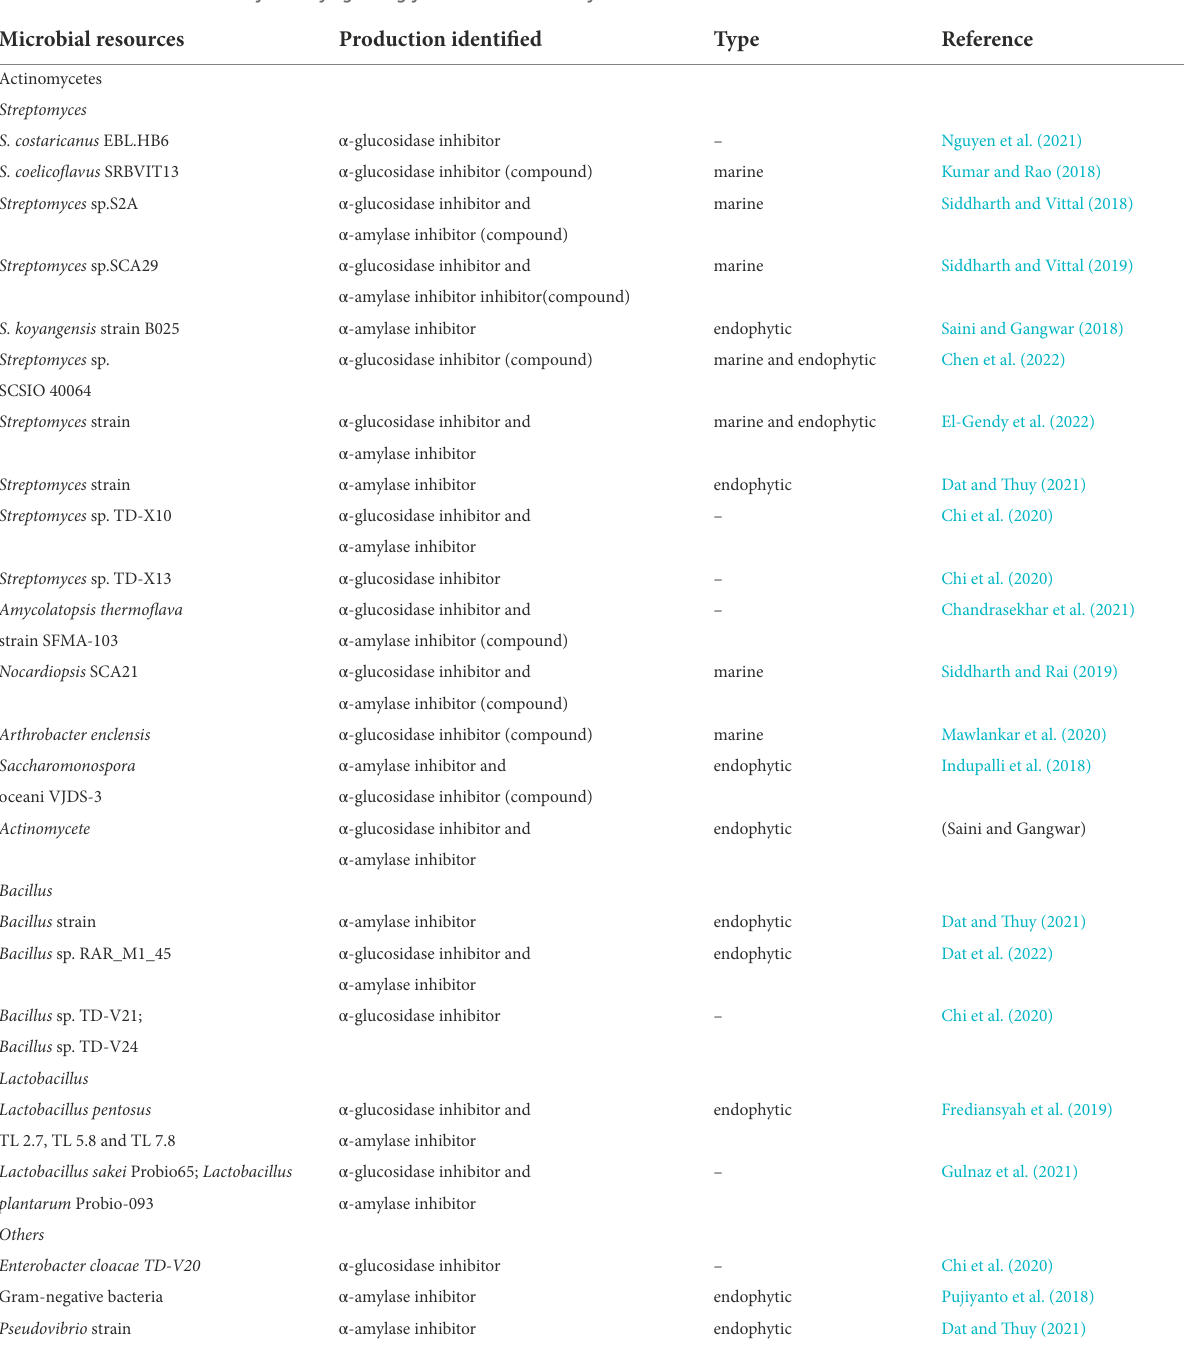
TABLE 1 Bacteria with inhibitory activity against glycosidase in recent 5